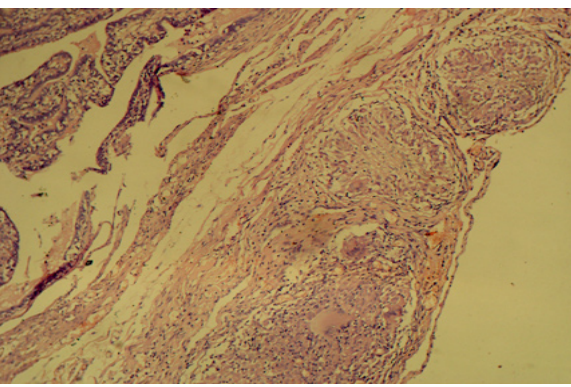
figure 3. Photomicrograph showing multiple epithelioid cell granulomas in subserosal layer of fallopian tube; an uncommon site for tuberculous involvement [HandE x100].